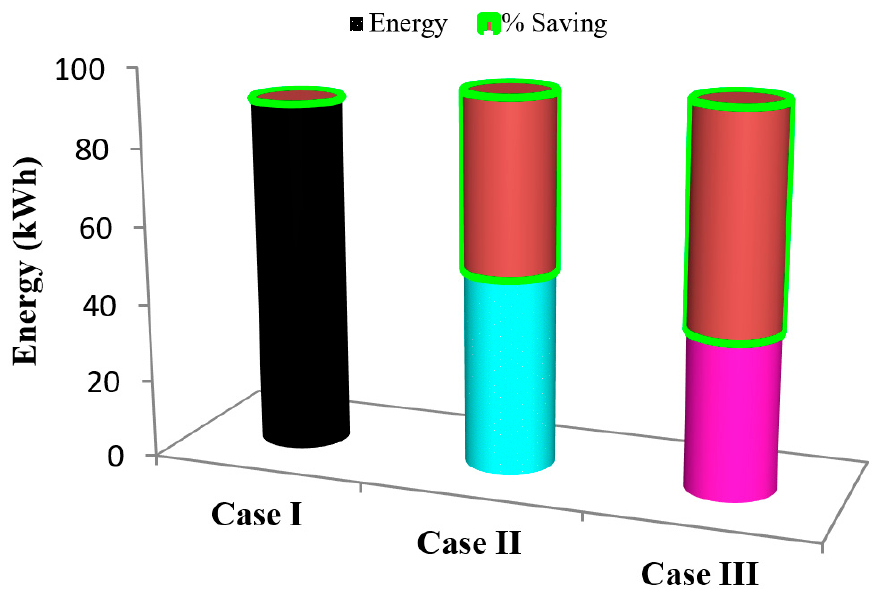
Figure 13. Percentage of energy savings management for 20 users within case-I, II, and III over 48 h time period.